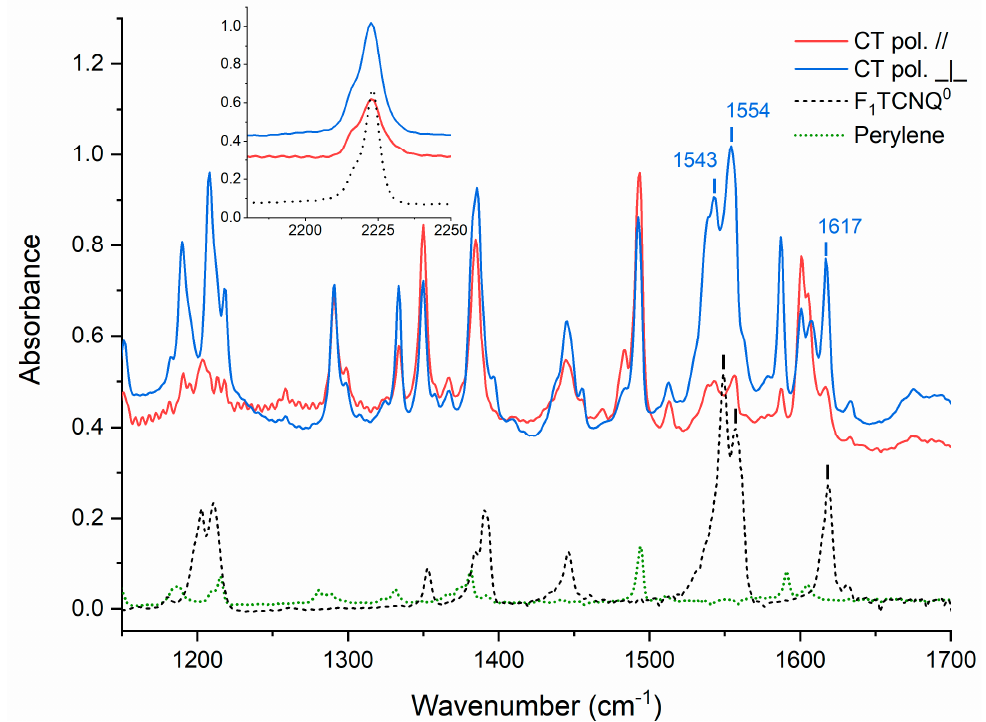
Figure 4. Polarized IR absorption spectra of Perylene–TCNQF 1 3:2 CT crystal.